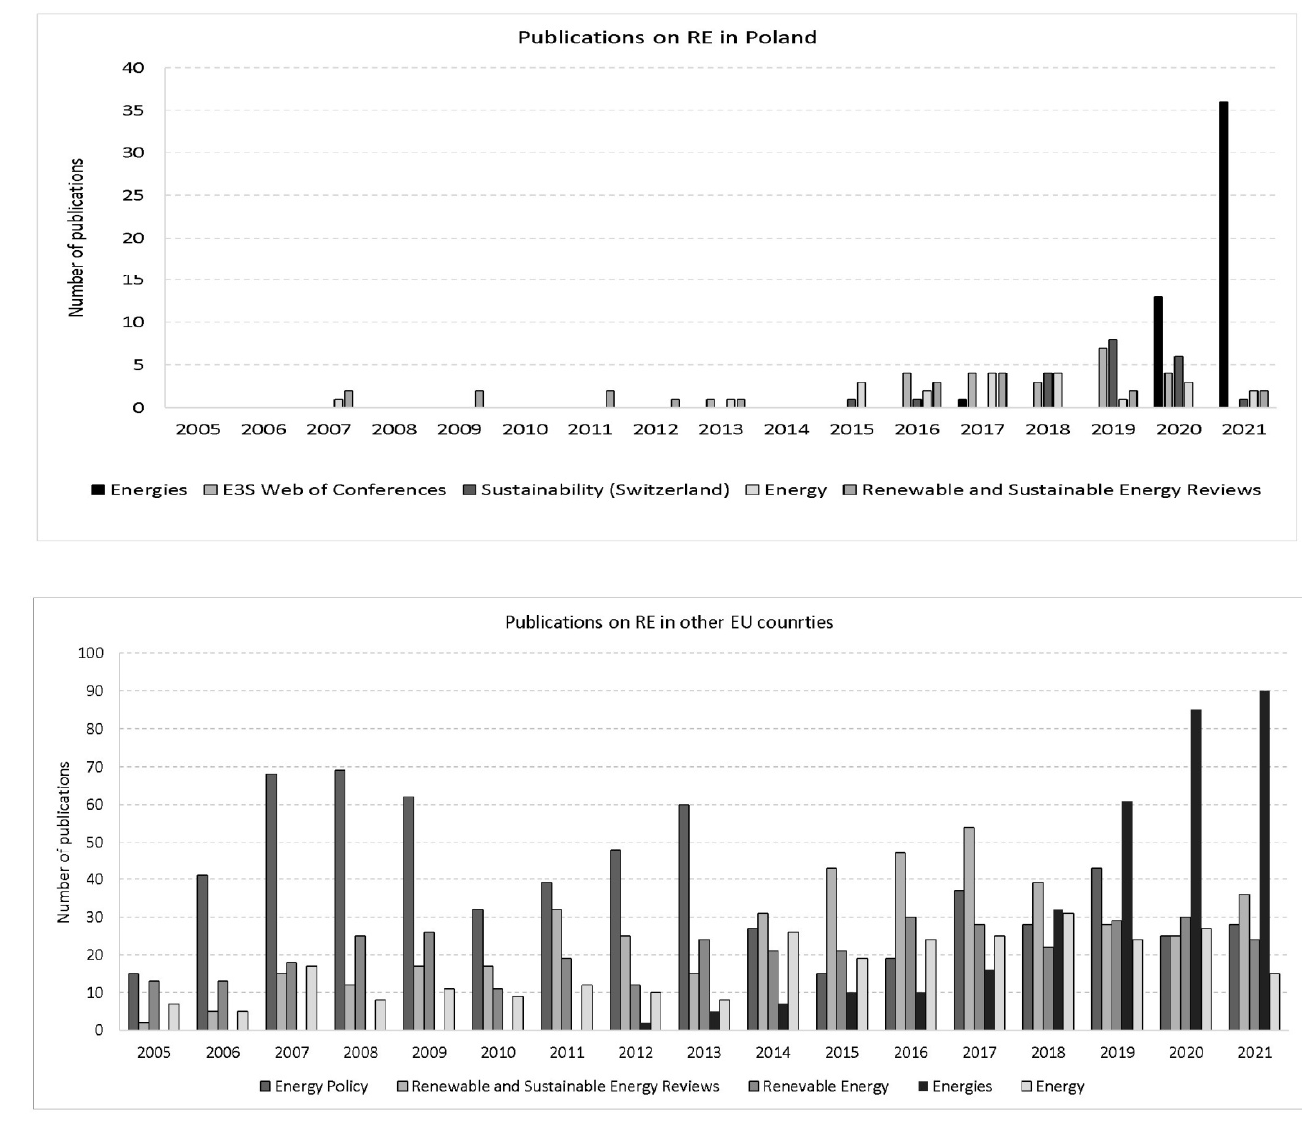
Figure 2. Publications on RE in the top five journals in 2005–2021 (Scopus,